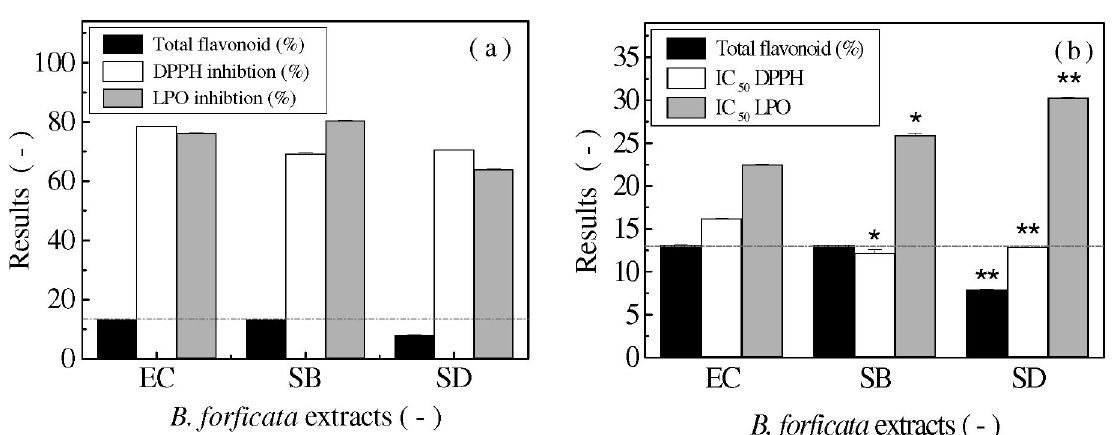
FIGURE 2 - Comparison between total flavonoid contents, maximum anti-radical activity (Fig. a), and IC forficata extracts. Statistical analysis was performed by one-way ANOVA followed by Bonferroni’s test of multiple comparisons test. * Significant statistical difference compared to EC ( P <0.05). ** Significant statistical difference compared to EC and SB ( P <0.05).